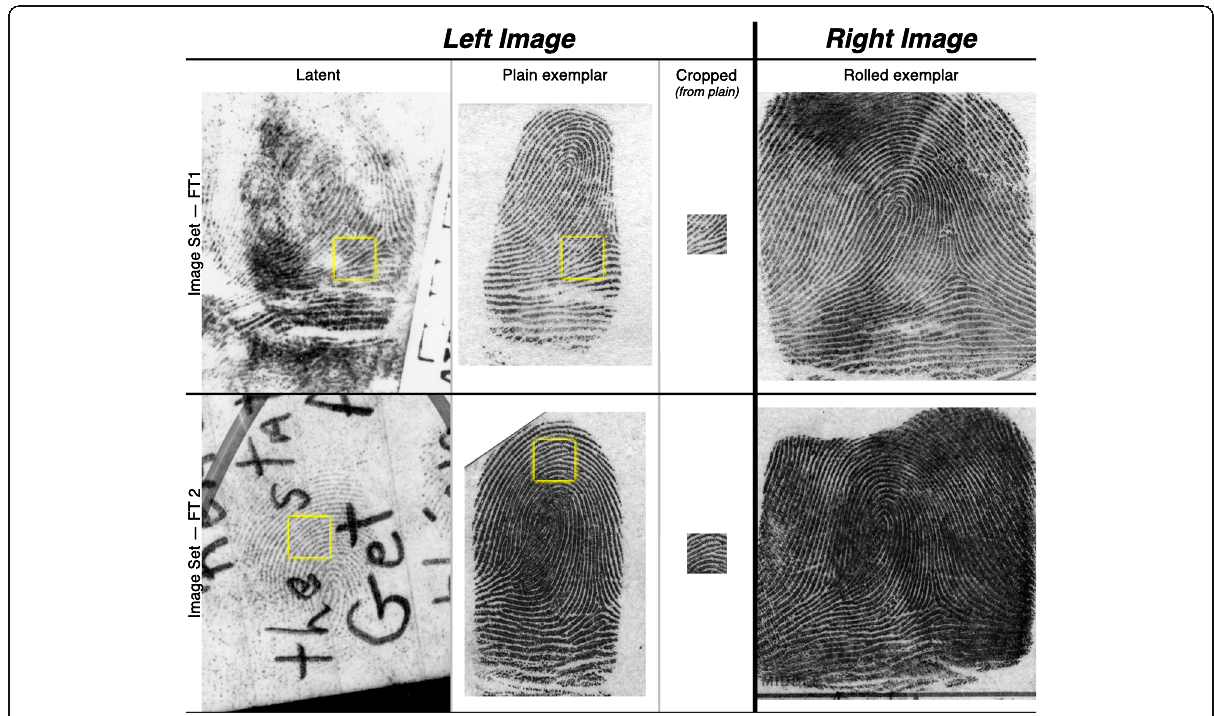
Fig. 1 Two example sets of images used in find-the-target tasks. In each trial, one of the left images (Latent, Plain, or Cropped) was paired with the right image (mated exemplar). The yellow squares indicating the target areas were in the images shown to the participants. All images are at the same scale. Target area is 3.8 mm × 3.8 mm. Latent images (left column) are slightly cropped for publication. See Additional file 1: Appendix SI-3 for the other image